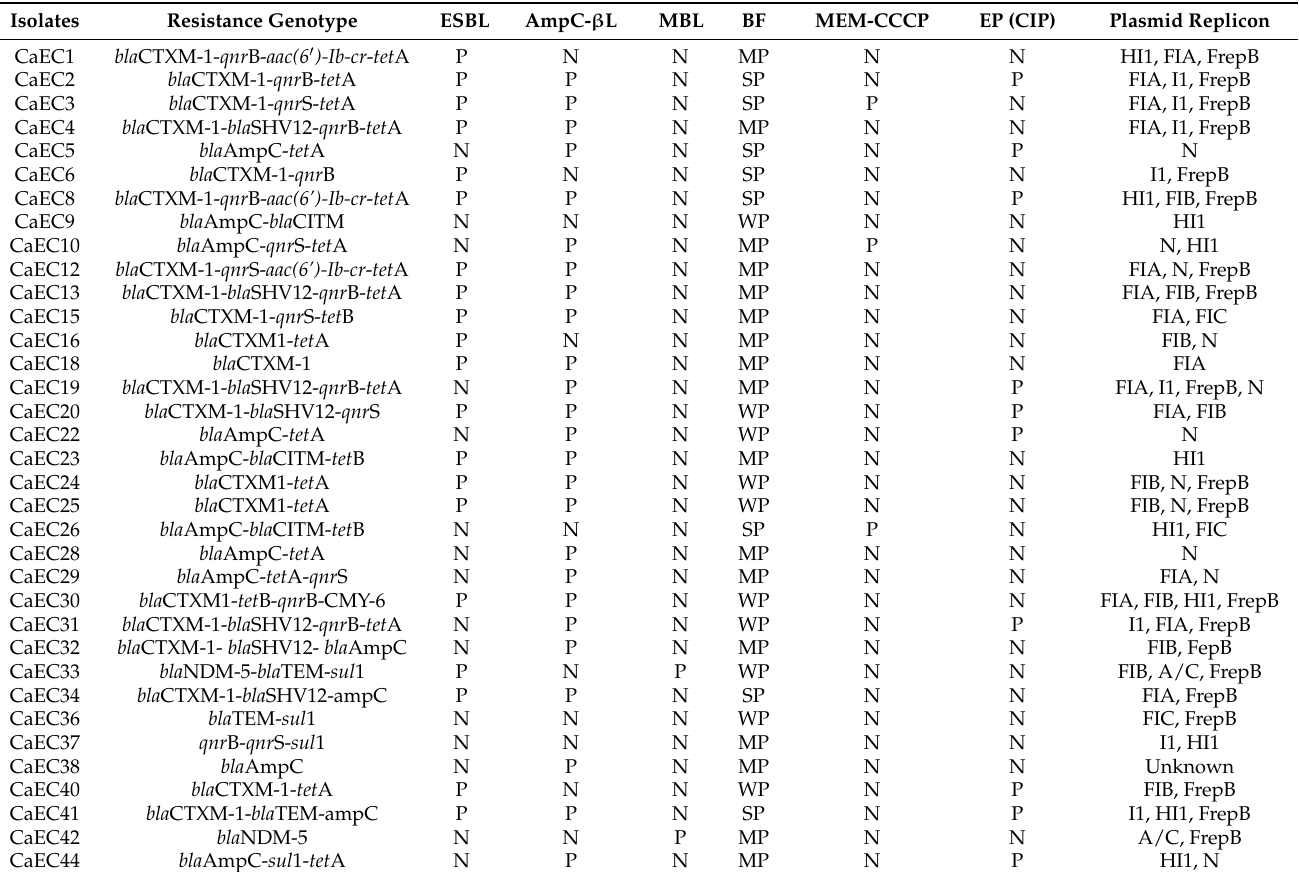
Table 2. Antibiotic resistance, β -lactamase production, efflux pump-mediated carbapenem and fluoroquinolone resistance, and plasmid profiling of multi-drug resistant Escherichia coli isolates of caprine origin in 4 different agro-climatic regions of West Bengal, India. Isolates Resistance Genotype